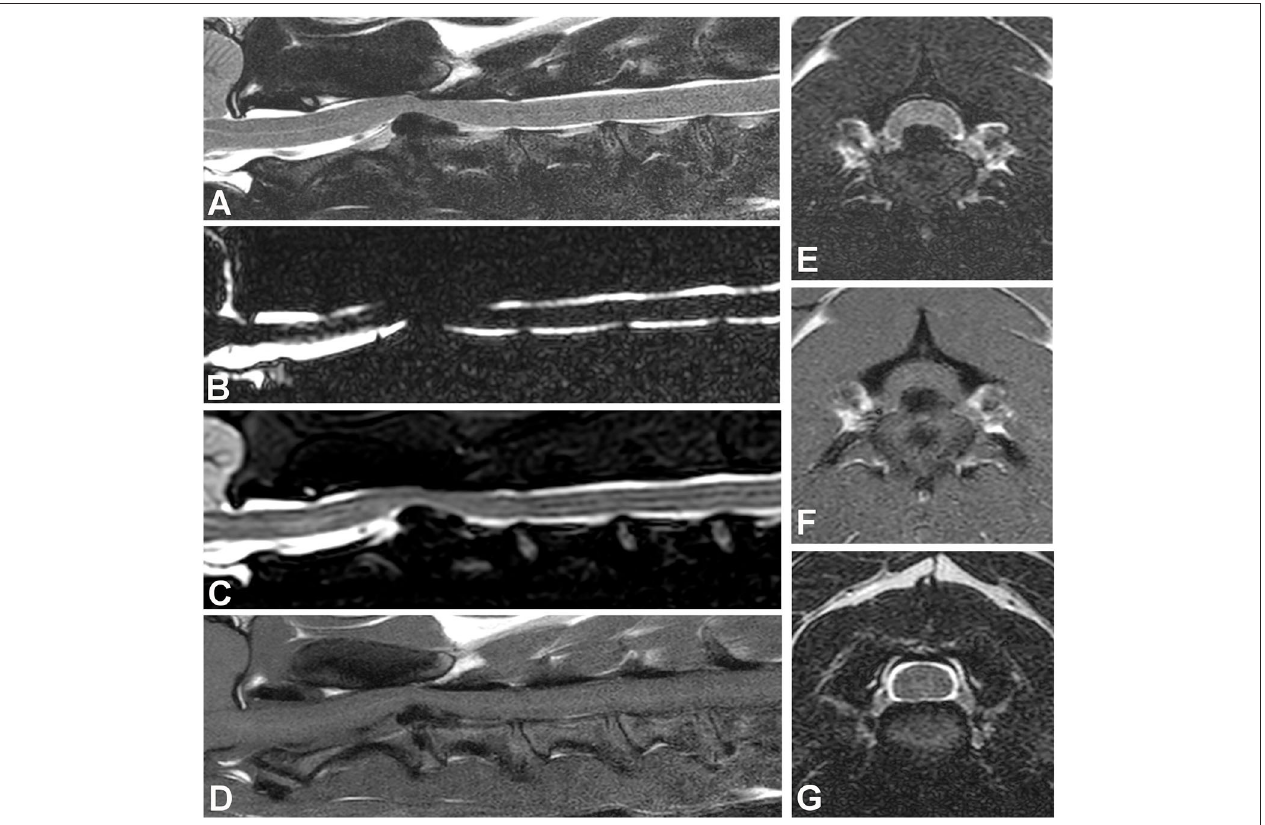
FIGURE 4 | Images of a dog with cervical intervertebral disc extrusion. (A) Sagittal T2W image. (B) Sagittal HASTE image. (C) Sagittal STIR image. (D) Sagittal T1W image. All sagittal images show ventral extradural compression in the ventral aspect of the vertebral canal at the intervertebral level C2-3. Note how the compressive material is hypointense in all images, though image resolution varies with different sequences. The signal of intervertebral discs in situ also varies in all sequences. (E) Transverse T2W image showing a large hypointense mass causing spinal cord compression at the C2-3 level. (F) Transverse T1W image showing the hypointense compressive material at C2-3. (G) Transverse T2W image showing the C3-4 level with no spinal cord